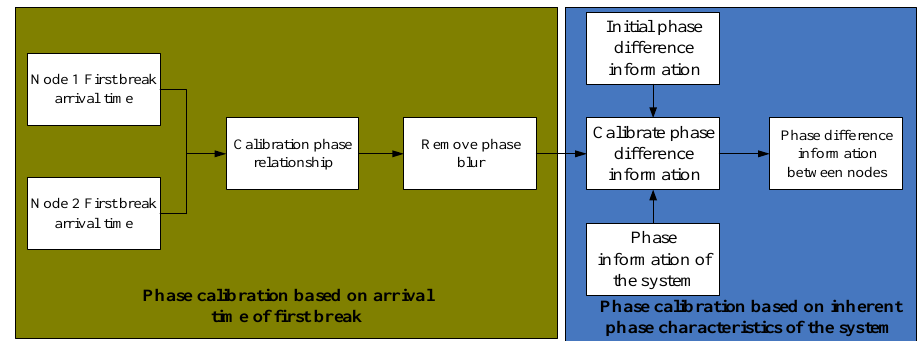
Figure 5. Schematic diagram of phase difference calibration.